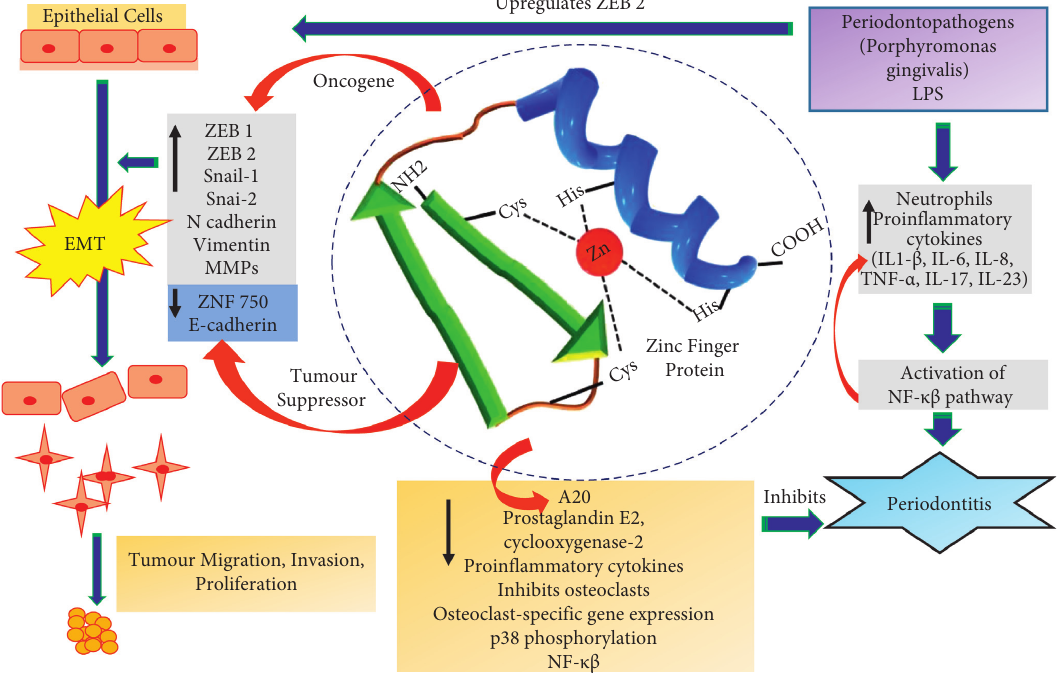
Figure 1: Zinc finger proteins in oral cancer and